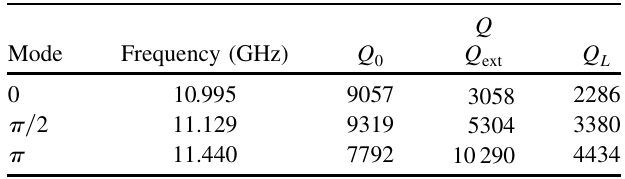
TABLE V. Q values for the various structure